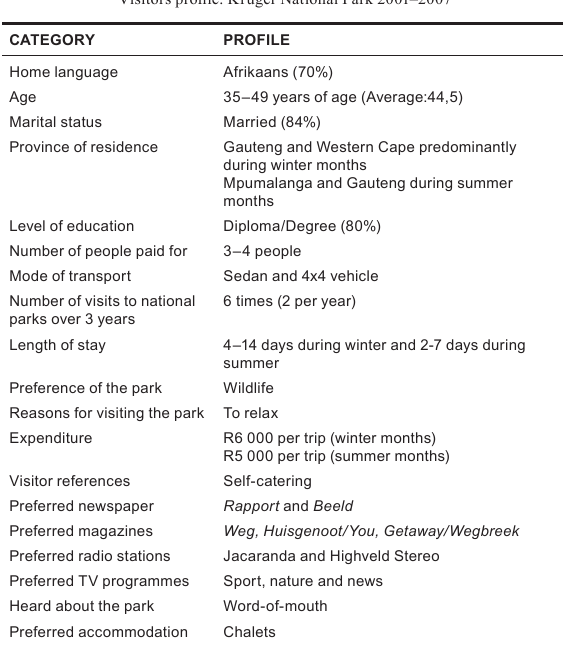
Table 3 Visitors profile: Kruger National Park